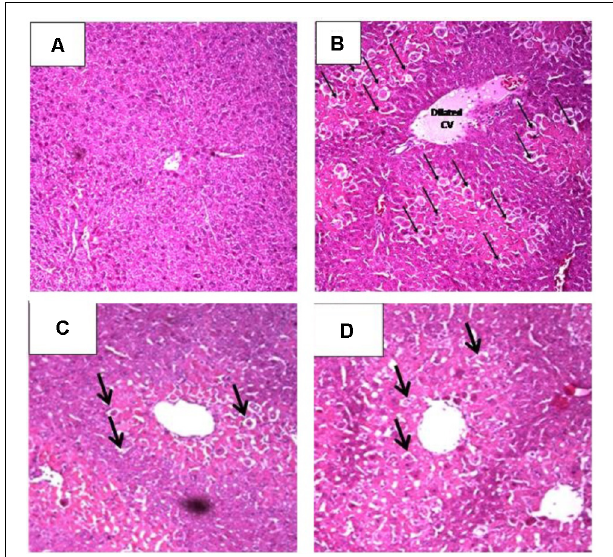
FIGURE 5 | Hepatoprotective potential of S. aqueum leaf extract on liver pathology after CCl 4 treatment in rats, stained by hematoxylin-eosin. (A) Liver of normal control rat with normal hepatic architecture, hepatocyte structure and central vein. (B) Liver afterCCl 4 intoxication with severe changes including dilated central vein with central hepatocellular necrosis (arrows) and congested portal triad. (C) Liver of a rat treated with silymarin prior to CCl 4 administration; only scattered cytoplasmic vacuolization (arrows) were detected. (D) Liver of a rat treated with the extract (200 mg/kg, b.w.) prior to CCl 4 injection showing scattered cytoplasmic vacuolization (arrows).